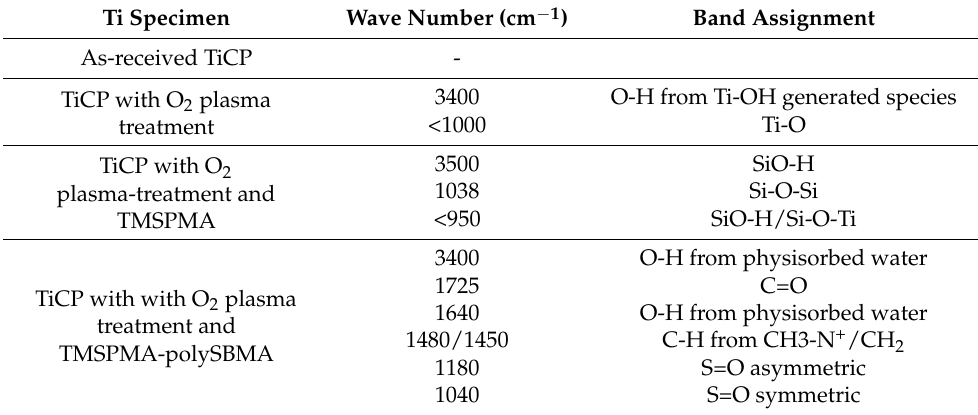
Table 2. FTIR band assignment of different TiCP sample